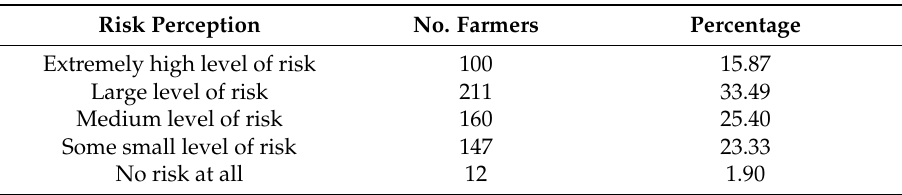
Table 4. Perceptions of pesticide risk on farmers’